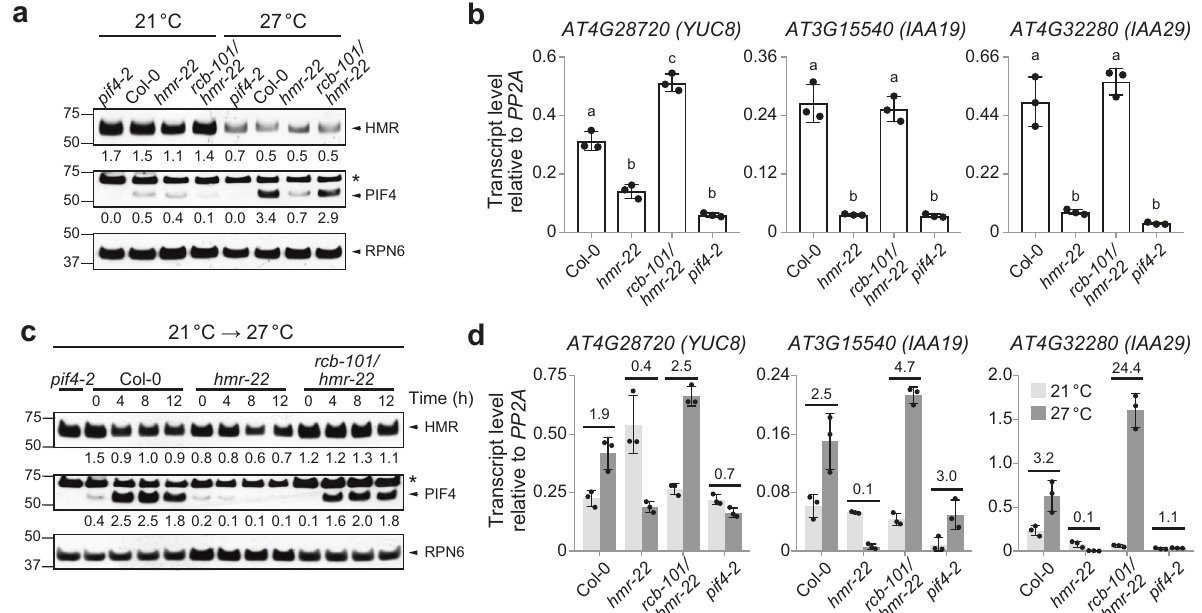
Fig. 2 rcb-101/hmr-22 restores PIF4 stability and activity. a Immunoblot analysis showing HMR and PIF4 levels in Col-0, hmr-22 , rcb-101/hmr-22 , and pif4-2 seedlings grown in 50 μ mol m − 2 s − 1 R light for 96 h at either 21 or 27 °C. b qRT-PCR analysis of the steady-state transcript levels of YUC8 , IAA19 , and IAA29 in Col-0, hmr-22 , rcb-101/hmr-22 , and pif4-2 seedlings grown in 50 μ mol m − 2 s − 1 R light for 96 h at 27 °C. Different letters denote statistically signi fi cant differences in the transcript levels (ANOVA, Tukey ’ s HSD, p < 0.01, n = 3 biological replicates). c Immunoblot analysis of HMR and PIF4 levels in Col-0, hmr-22 , rcb-101/hmr-22 , and pif4-2 seedlings during the 21 to 27 °C transition. Seedlings were grown in 50 μ mol m − 2 s − 1 R light for 96 h and then transferred to 27 °C in the same light condition. Samples were collected and analyzed at the indicated time points. For ( a , c ) RPN6 was used as a loading control. The relative levels of HMR and PIF4, normalized to RPN6, are shown underneath the respective immunoblots. The asterisks indicate non-speci fi c bands. The immunoblot experiments were independently repeated at least three times, and the results of one representative experiment are shown. d qRT- PCR analysis of the steady-state transcript levels of YUC8 , IAA19 , and IAA29 in Col-0, hmr-22 , rcb-101/hmr-22 , and pif4-2 during the 21 to 27 °C transition. Seedlings were grown as described in ( c ), samples were taken before (light gray) and 24 h after (dark gray) the 27 °C treatment. Fold changes in the transcript levels after the 27 °C treatment are shown above the columns. For ( b , d ), transcript levels were calculated relative to those of PP2A . Error bars represent the s.d. of three biological replicates. The centers of the error bars represent the mean values. The source data of the immunoblots in ( a , c ) and the qRT-PCR data in ( b , d ) are provided in the Source Data fi